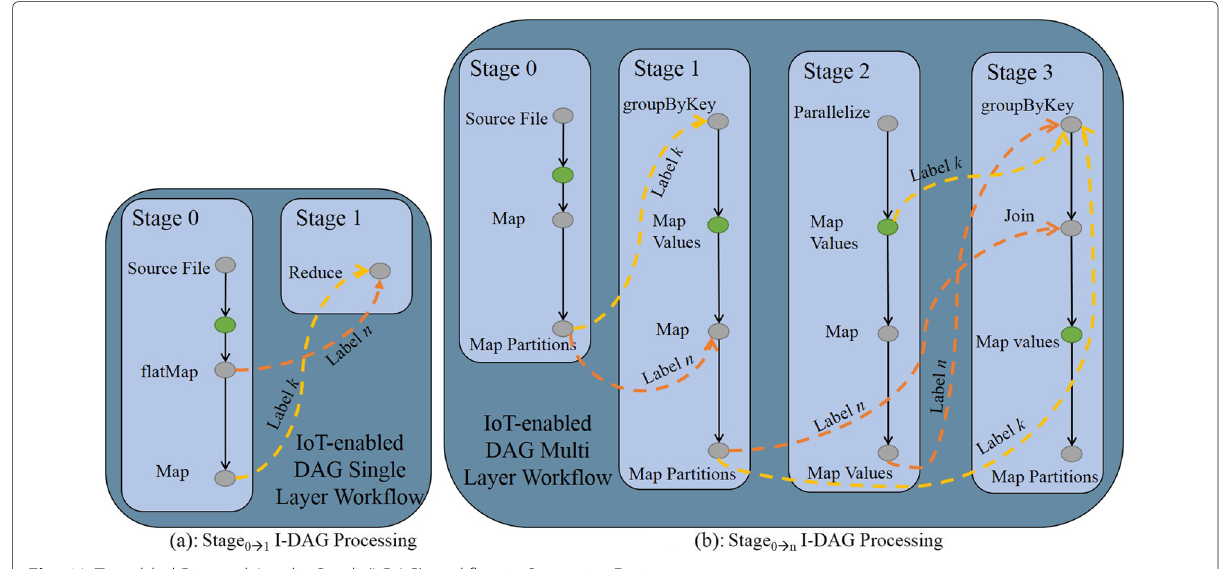
Fig. 6 IoT-enabled Directed Acyclic Graph (I-DAG) workflow in Streaming Engine